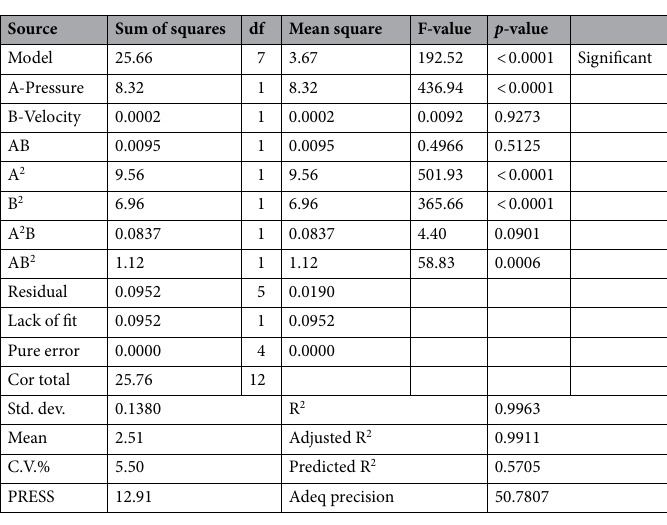
Table 7. ANOVA results of quadratic model (wear rate is response) for QAM f steel.